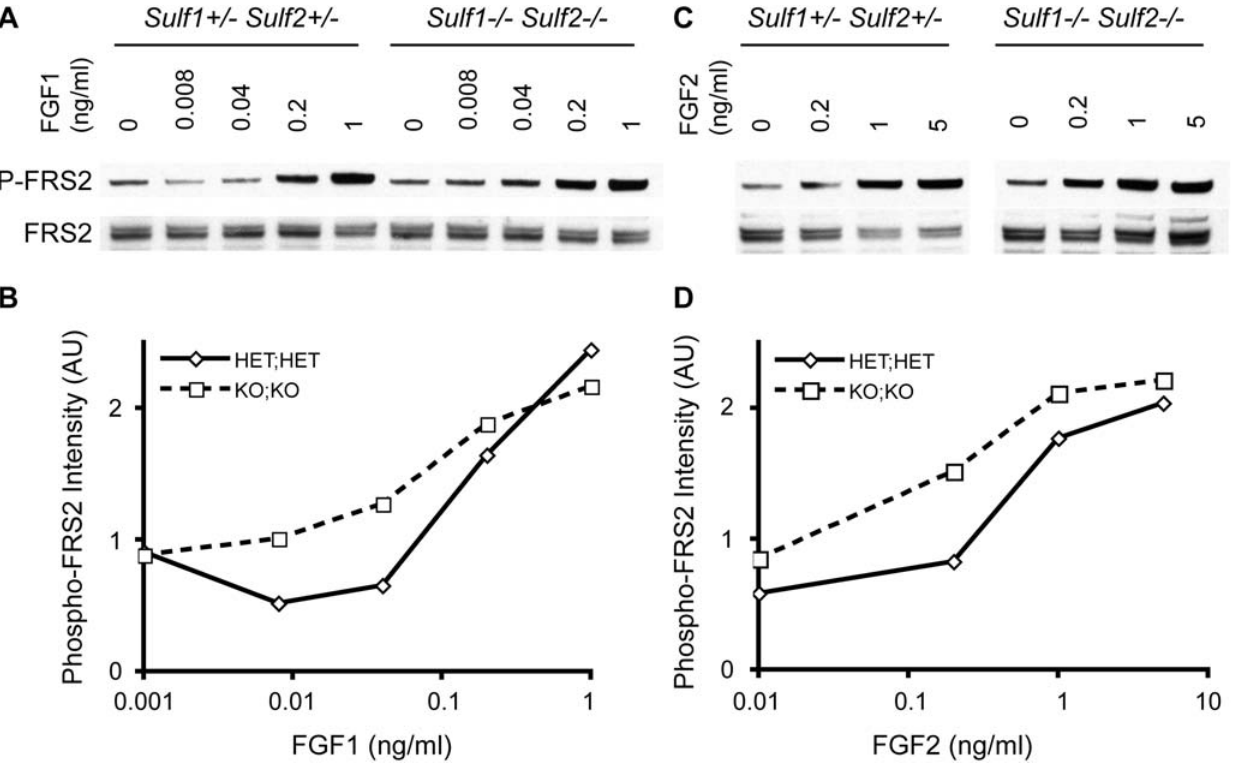
Figure 5. Sulf1 2 / 2 Sulf2 2 / 2 embryonic fibroblasts are hyper-sensitive to fibroblast growth factors. Fibroblasts were stimulated with differing doses of FGF1 (A, B) or FGF2 (C, D) for 10 minutes, then assessed for activation of signaling by Western analysis of phosphorylated FRS2. Results are representative of three independent experiments.